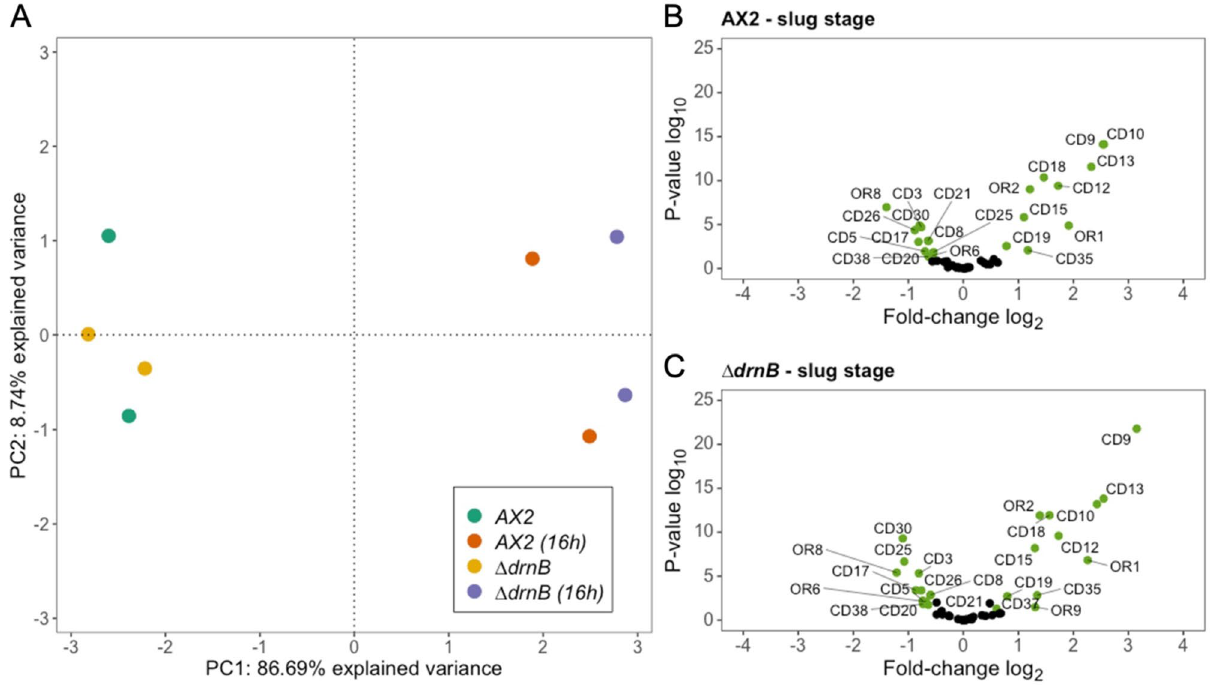
Figure 6. Analysis of box C/D snoRNA expression in axenic growth and development of the AX2 and ∆drnB strains. ( A ) Principal component analysis (PCA) of data from RNA-seq on the indicated strains and conditions. Volcano plots of box C/D snoRNA expression changes in the slug stage of AX2 ( B ) and ∆drnB ( C ). Significantly up- or downregulated box C/D snoRNAs are labelled and colored